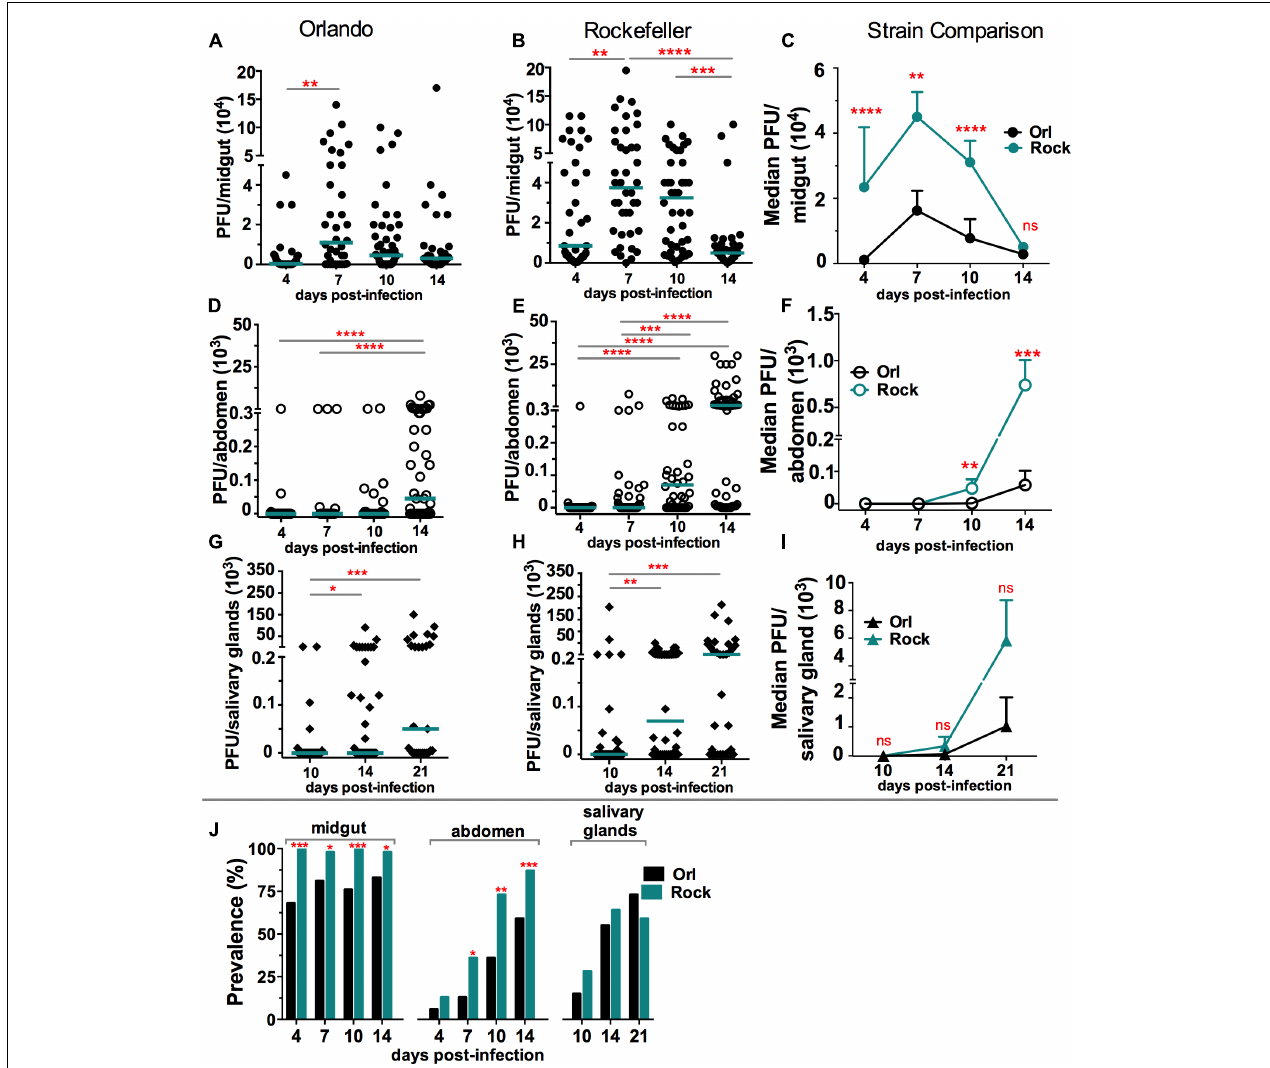
FIGURE 1 | Zika virus (ZIKV) tropism in A. aegypti . Orlando (Orl) and Rockefeller (Rock) A. aegypti mosquito strains were infected with ZIKV via an infectious-blood meal, and (A–C) midguts, (D–F) abdomens, and (G–I) salivary glands were assessed for infection intensity at different time points. (A) 4 days ( N = 34), 7 days ( N = 36), 10 days ( N = 46), 14 days ( N = 36). (B) 4 days ( N = 37), 7 days ( N = 40), 10 days ( N = 42), 14 days ( N = 42). (D) 4 days ( N = 35), 7 days ( N = 38), 10 days ( N = 25), 14 days ( N = 51). (E) 4 days ( N = 56), 7 days ( N = 61), 10 days ( N = 40), 14 days ( N = 55). (G) 10 days ( N = 33), 14 days ( N = 38), 21 days ( N = 27). (H) 10 days ( N = 40), 14 days ( N = 46), 21 days ( N = 34). Each dot represents the plaque-forming units (PFUs) per individual tissue from three independent experiments. Bars represents the median. ∗ P < 0.05, ∗∗ P < 0.01, ∗∗∗ P < 0.001; Kruskal-Wallis test. (C,F,I) show strain comparisons between Orl and Rock; each point represents the median PFU per strain at the given time point per replicate ( N = 3). ∗∗ P < 0.01, ∗∗∗ P < 0.001, ∗∗∗∗ P < 0.0001; Mann–Whitney test. (J) The prevalence (percentage) of infected mosquitoes for Orl vs. Rock was compared at each time point. ∗ P < 0.05, ∗∗ P < 0.01, ∗∗∗ P < 0.001; chi square test.